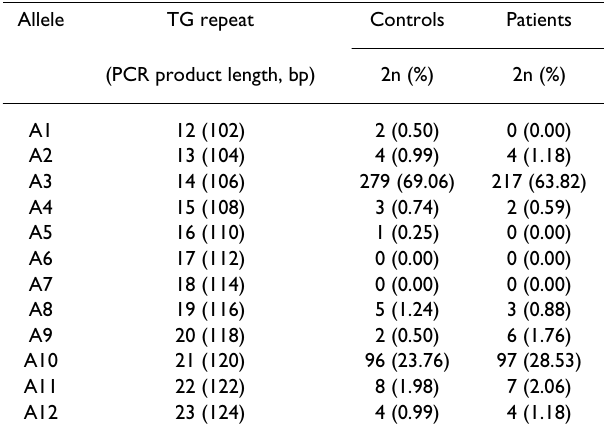
/(TG) , (TG) / Table 2: Allele frequencies of the Flt-1 (TG) n polymorphism in 14 14 14